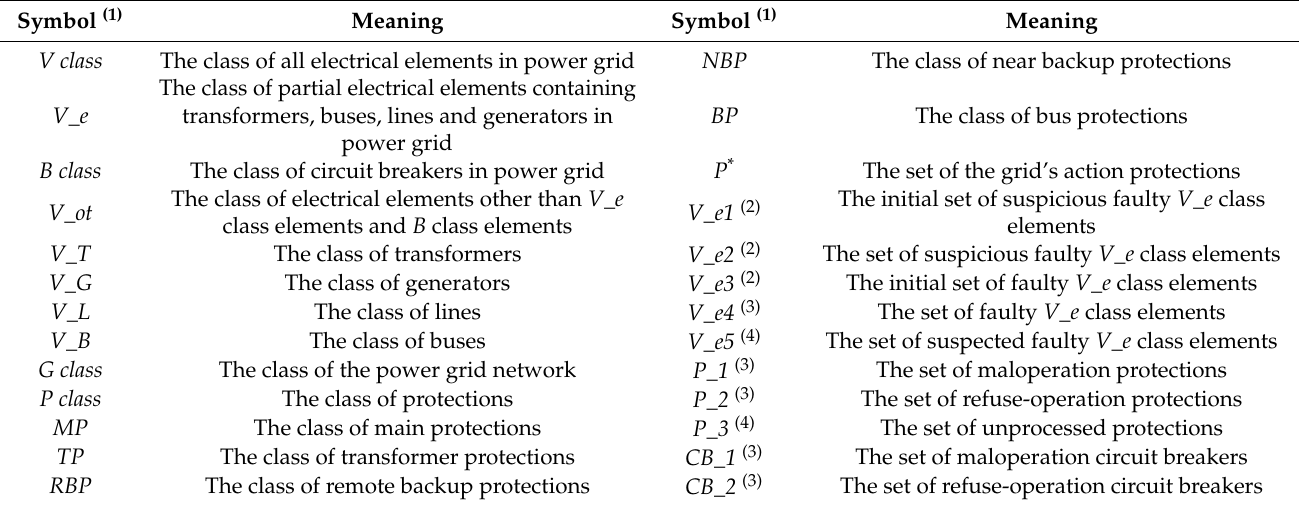
Table 1. Table of main